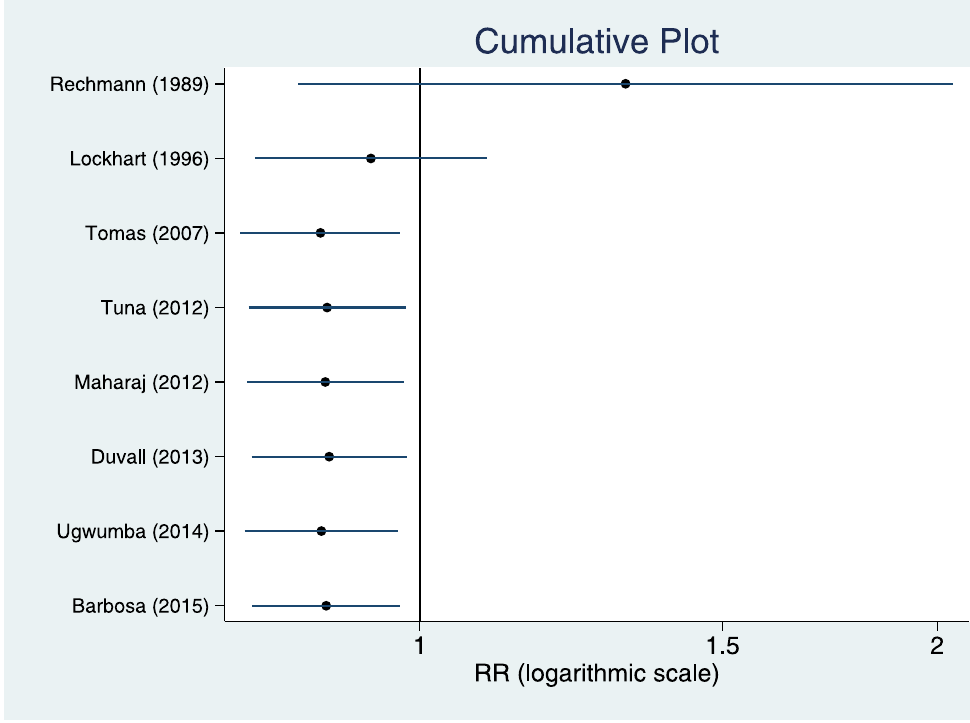
Fig 6. Cumulative meta-analysis by year of publication. Cumulative plot showing the time tendency of relative risk for the incidence of bacteremia.